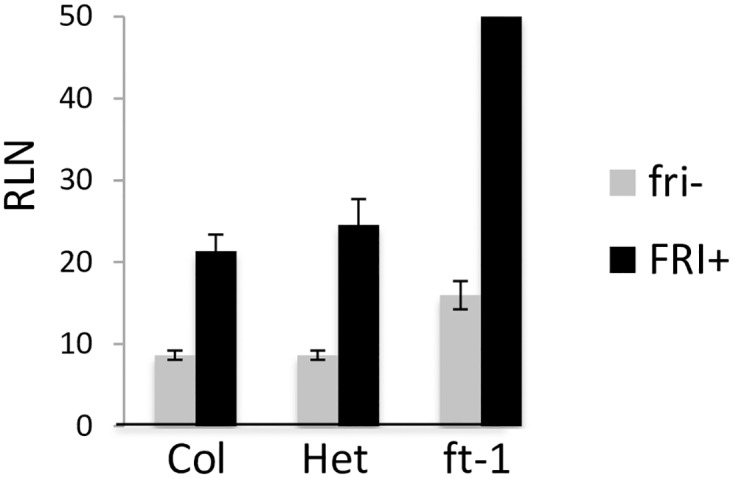
Two loci, FRI and FT, are sufficient to confer FR insensitivity.An FT mutant in Col was integrated into the ColFRI background, to demonstrate the role of FT in a late-flowering strain. In the ColFRI background, FT is necessary for FR sensitivity.